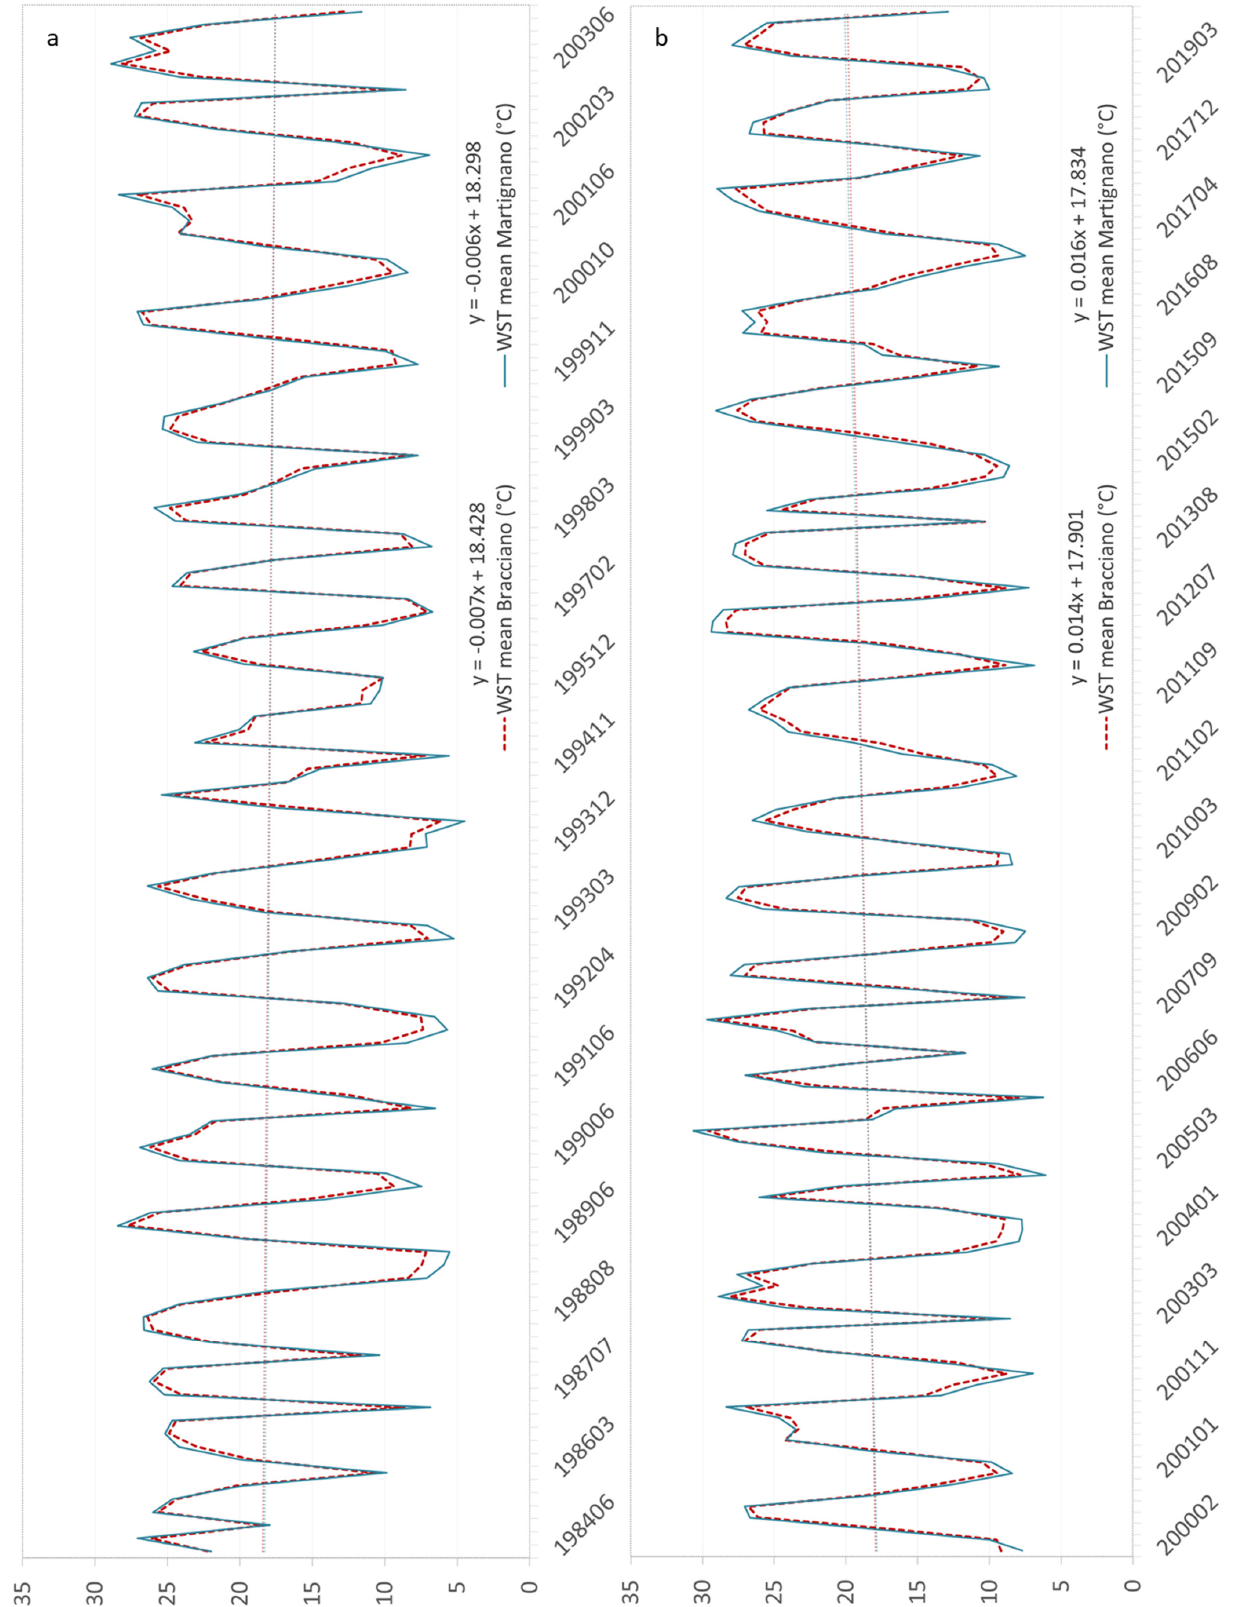
Figure 6. Split of Figure 5 considering two time intervals of two decades: from 1984 to 2003 ( a ) and from 2000 to 2019 ( b ).